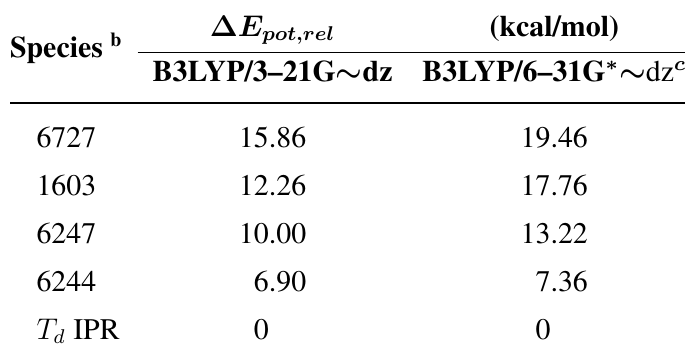
Table 2. La@C relative potential energies ∆ E 76 optimized geometries.